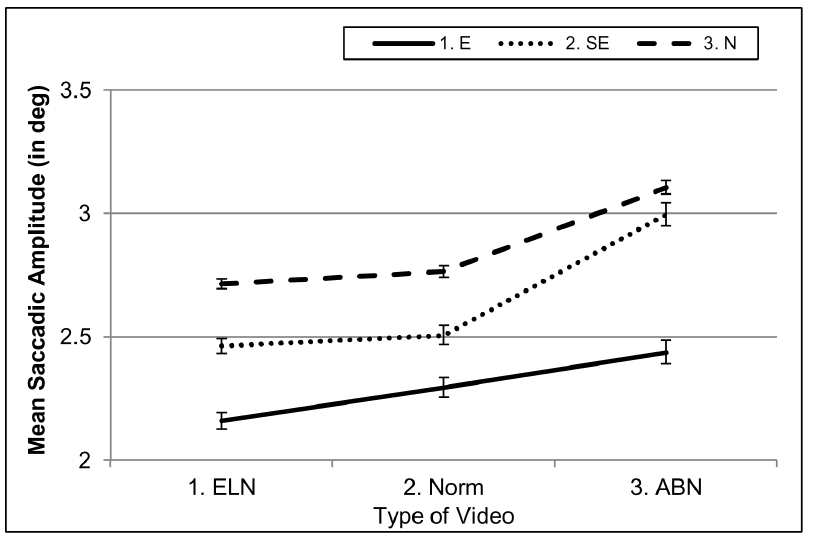
Figure 6. Interaction between Expertise and Video for saccadic amplitude. The figure depicts that semi-experts and to some extent naı¨ve participants used longer saccades in ABN-videos than in other videos, whereas experts did not.